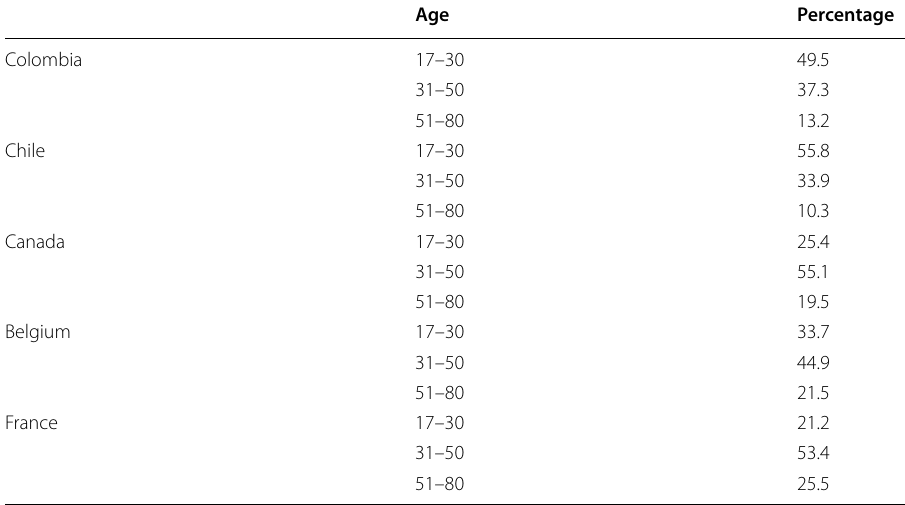
Table 2 Percentage distribution of respondents by age